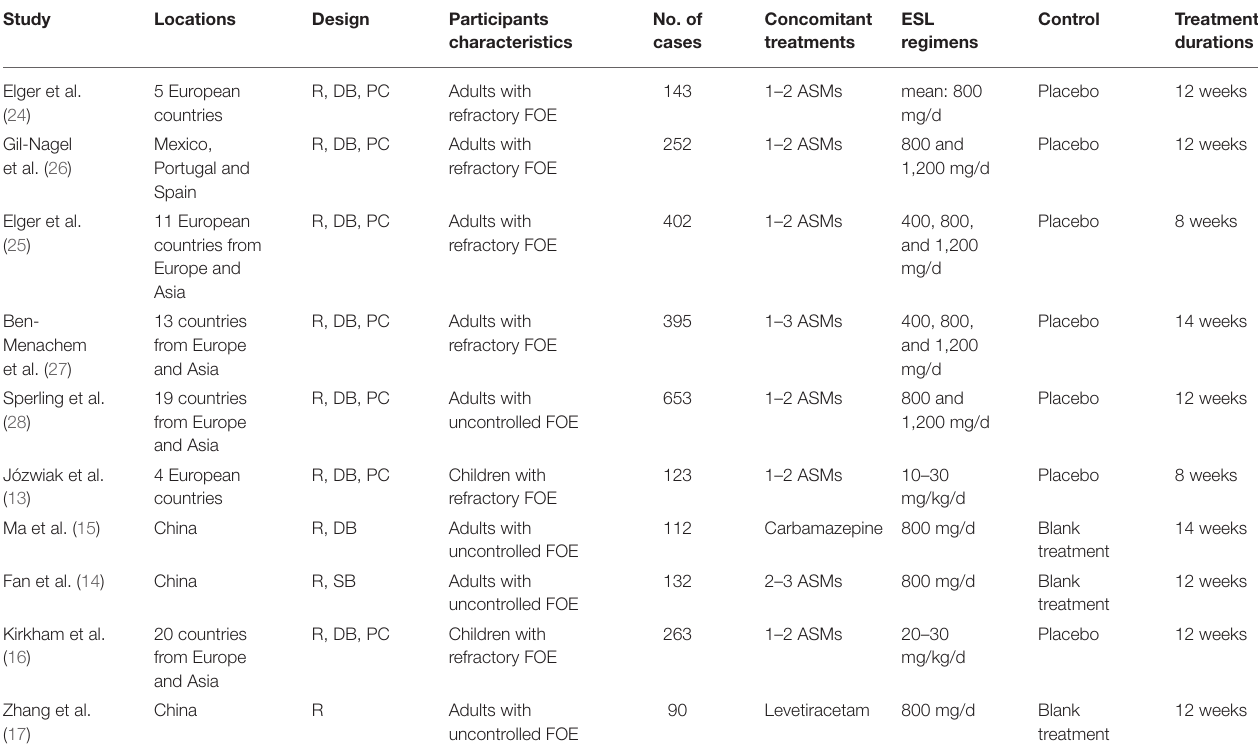
TABLE 1 | Characteristics of included clinical studies.